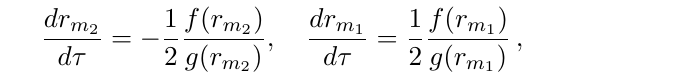
Figure 10. Here we show plots of r m have set r + /‘ = 10 , while the different plots correspond to r − /r + = 1 / 20 , 1 / 10 , 3 / 4 (left to